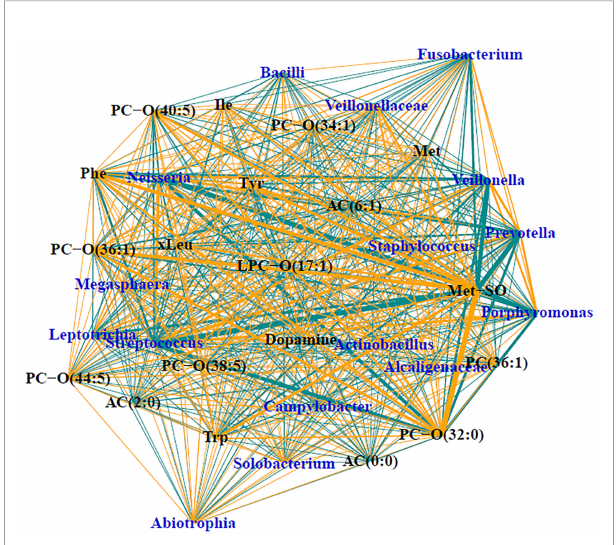
FIGURE 4 | Trimmed module subnetwork identifying microbiome- metabolome correlations with the CF phenotypic outcome. Yellow edges indicate positive correlations and turquoise edges indicate negative correlations. Wider network edges indicate stronger correlations. Blue nodes are taxa identi fi ed in 16S and black nodes are metabolites.